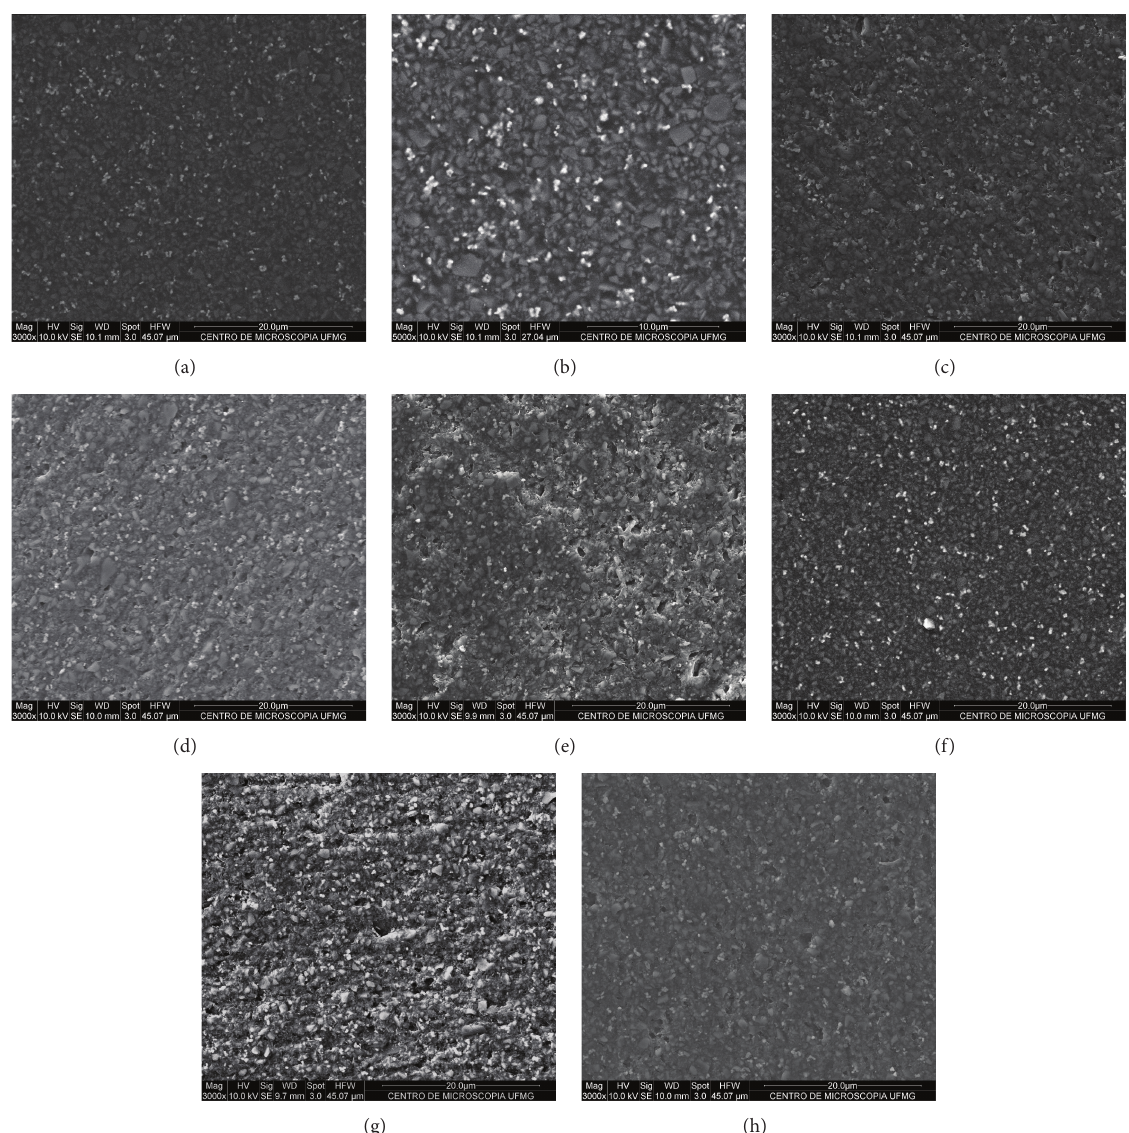
Figure 1: SEM images of silorane-based composite resin surface: (a) control, without surface finishing and polishing 3,000x magnification and (b) 5,000x magnification; (c) surface finished and polished with the Astropol immediately and (d) after 7 days (3,000x); (e) surface finished and polished with Enhance system immediately and (f) after 7 days (3,000x); and (g) surface finished and polished with Sof-Lex discs immediately and (h) after 7 days